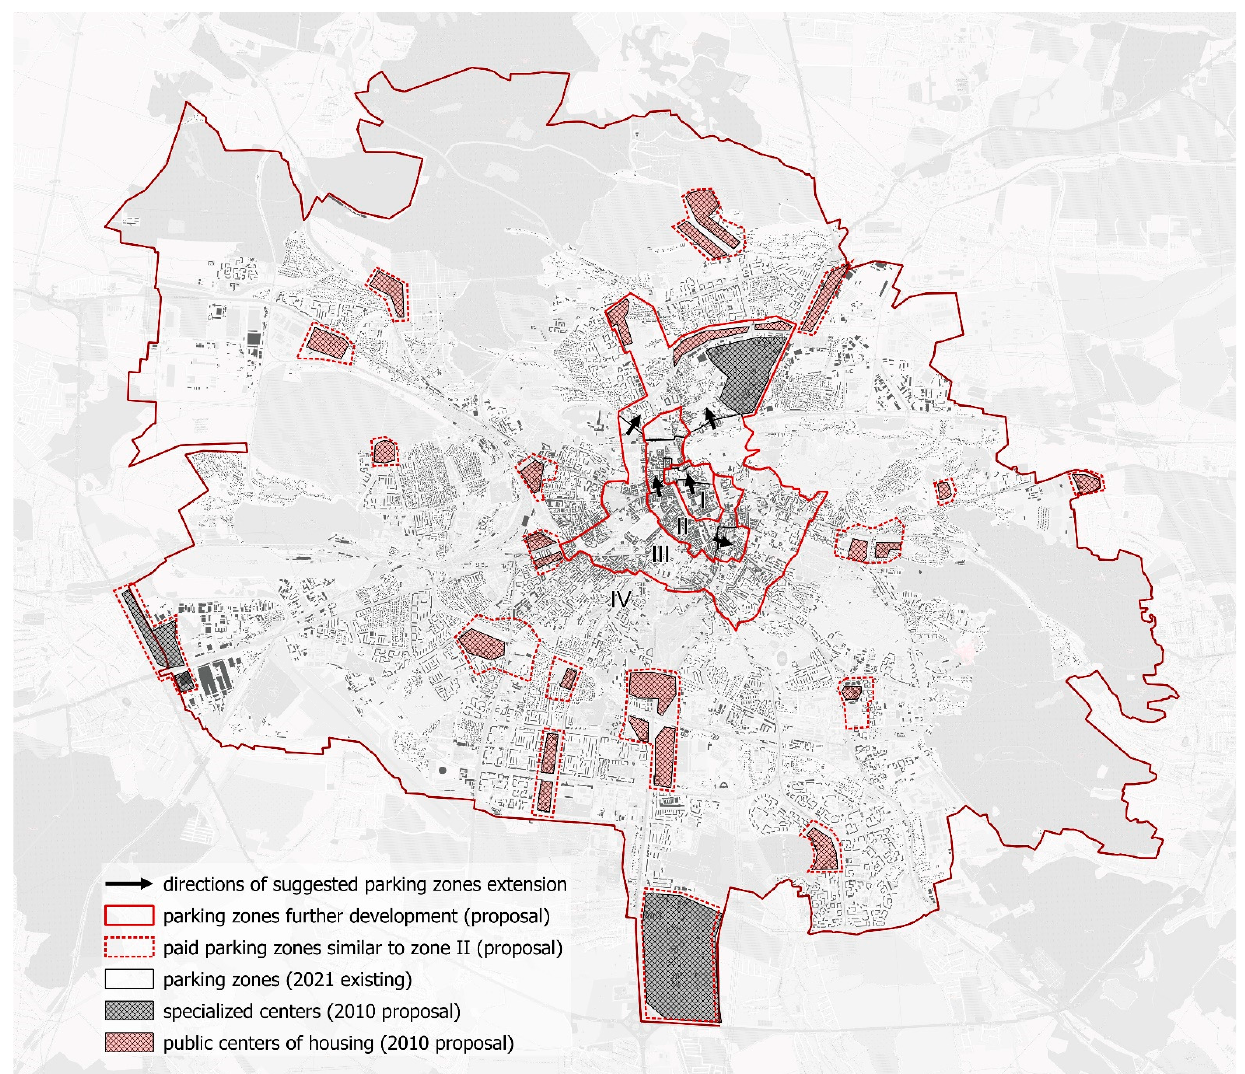
Figure 15. The suggested plan for developing parking zones based on demand. The scheme by H. Petryshyn and R. Liubytskyi. Petryshyn and R.